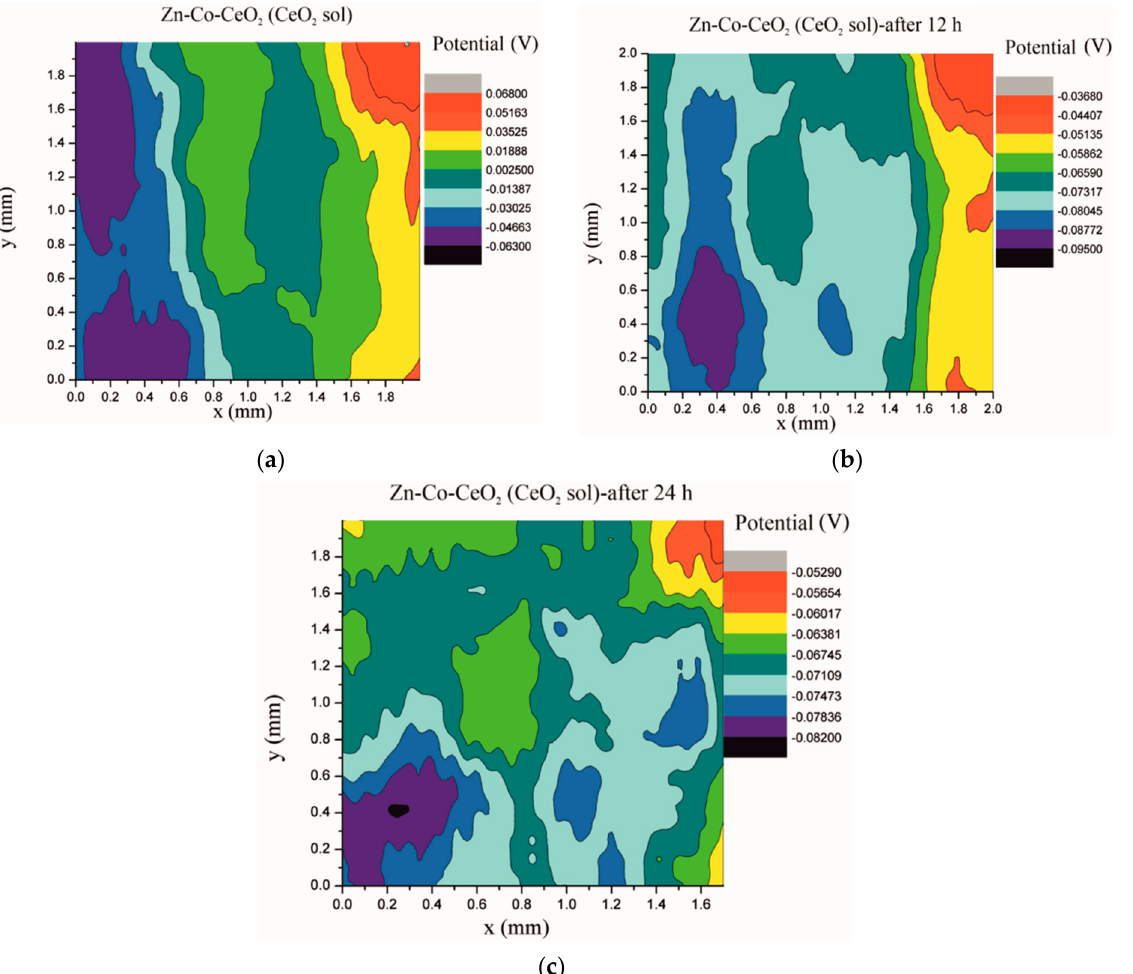
Figure 18. Volta potential surface scan of Zn-Co-CeO 2 (CeO 2 sol) coating: ( a ) initial distribution, ( b ) after 12 h and ( c ) after 24 h in device chamber.